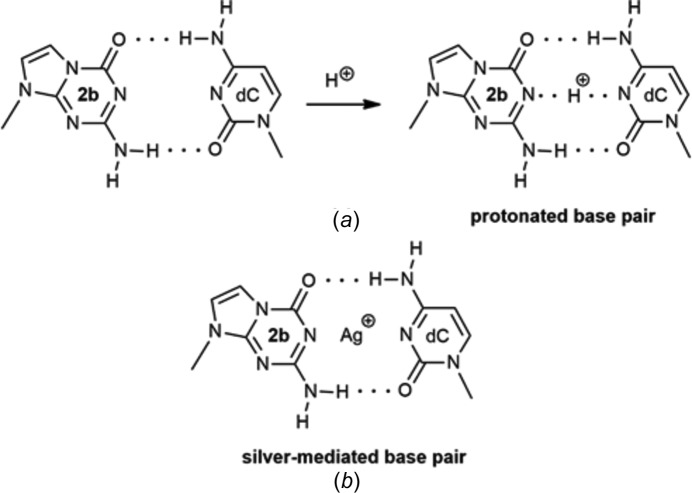
(a) Protonated base pair of 5-aza-7-de­aza-2′-de­oxy­guanosine (2b) and 2′-de­oxy­cytidine formed in acidic medium. (b) Silver-mediated base pair of 2b and dC.